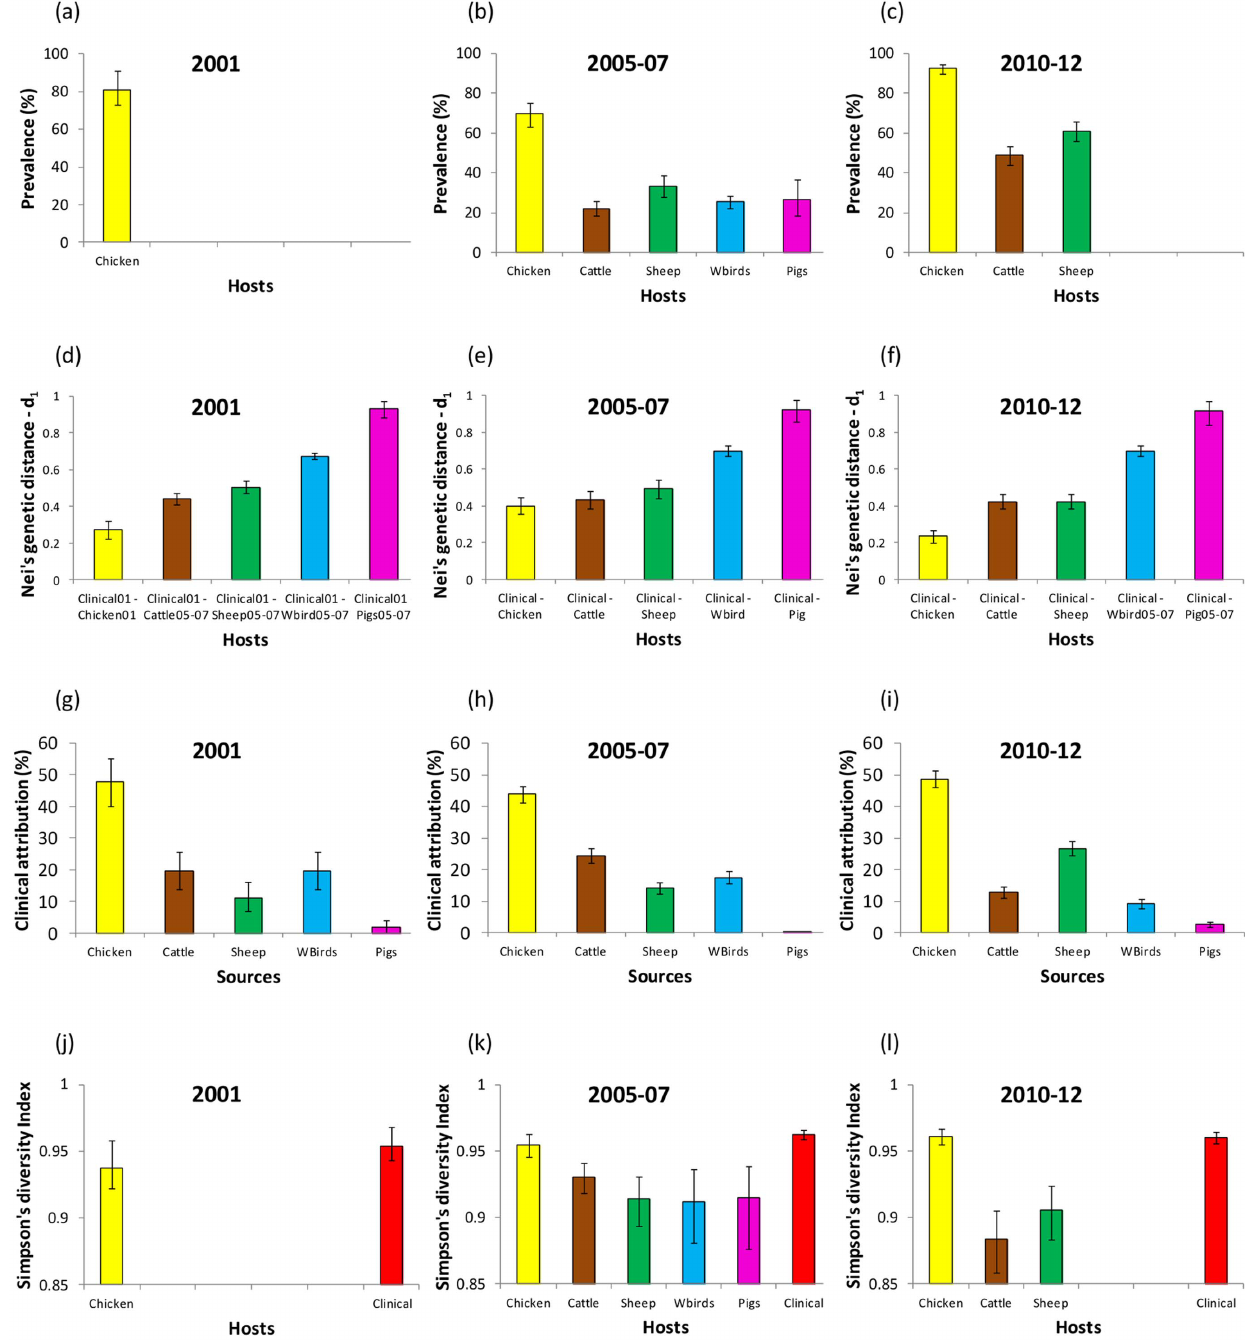
Figure 2. Host prevalence (a)–(c), genetic distance between human clinical and host genotypes (d)–(f), source attribution by STRUCTURE (g)–(i) and Simpson’s index of diversity (j)–(l) for the three time periods (2001, 2005–07 and 2010–12).